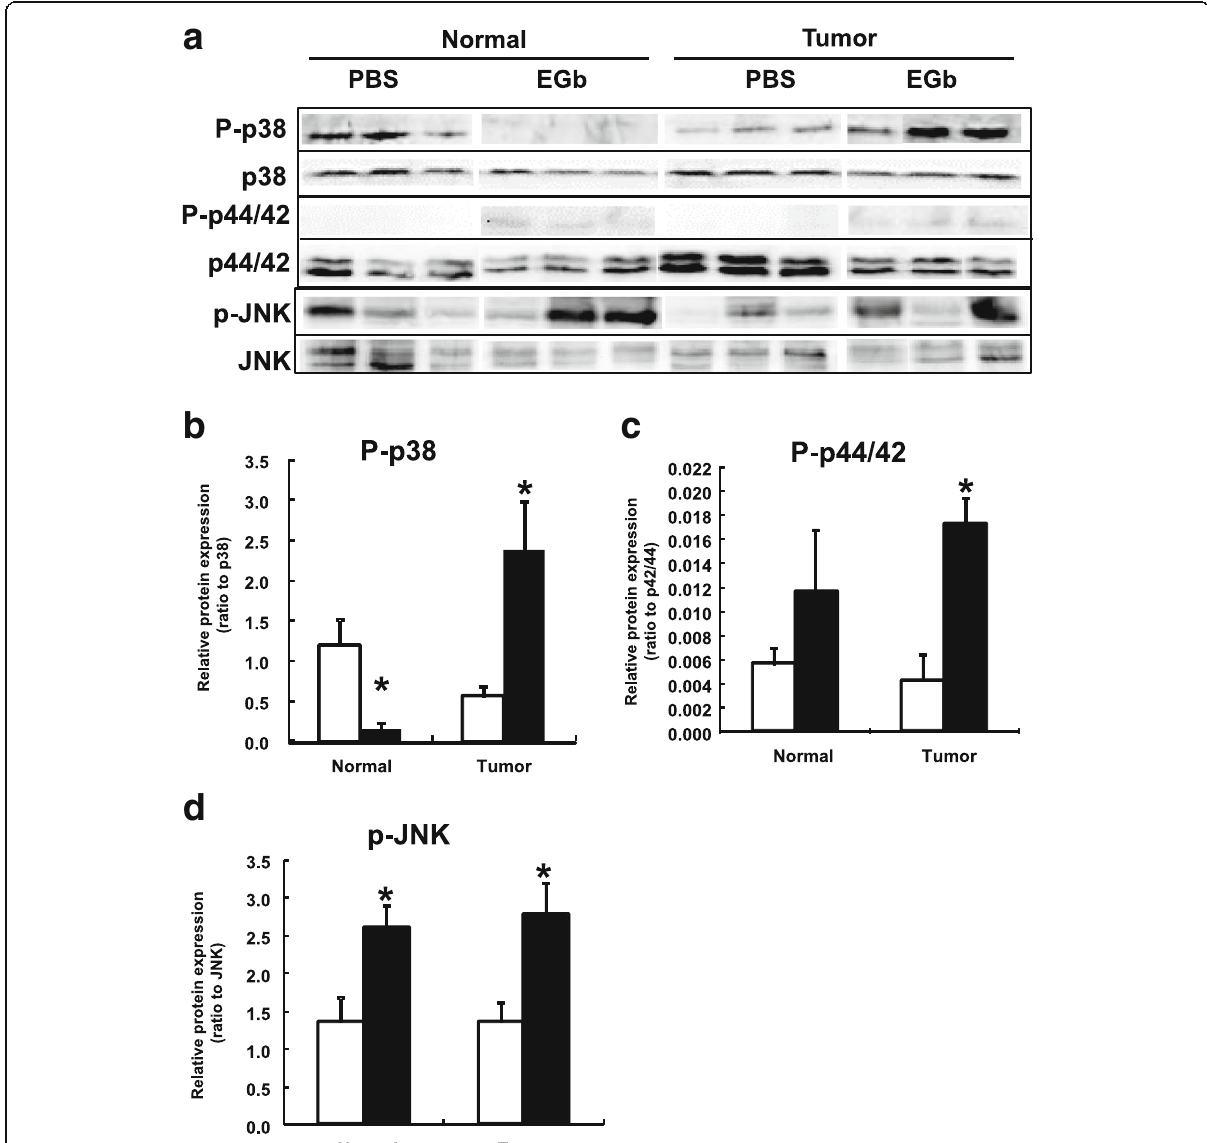
Fig. 4 Western blot analysis of proteins in the mitogen-activated protein kinase (MAPK) pathway in mouse liver. a Representative western blots of total and phosphorylated MAPK family proteins p38, p44/42, and JNK. Normal represents liver samples of animals without any tumor, while Tumor represents liver samples of animals with tumors. b , c , d Quantification of phosphorylated p38, p44/42, and JNK, respectively. Open bars represent the PBS control group, and filled bars represent EGb-treated group. Y-axis represents the ratio of the phosphorylated protein to the total level of respective protein. Values are means ± SEM, n > 5. Asterisks (*) indicate statistical significance ( p < 0.05) when compared to the PBS